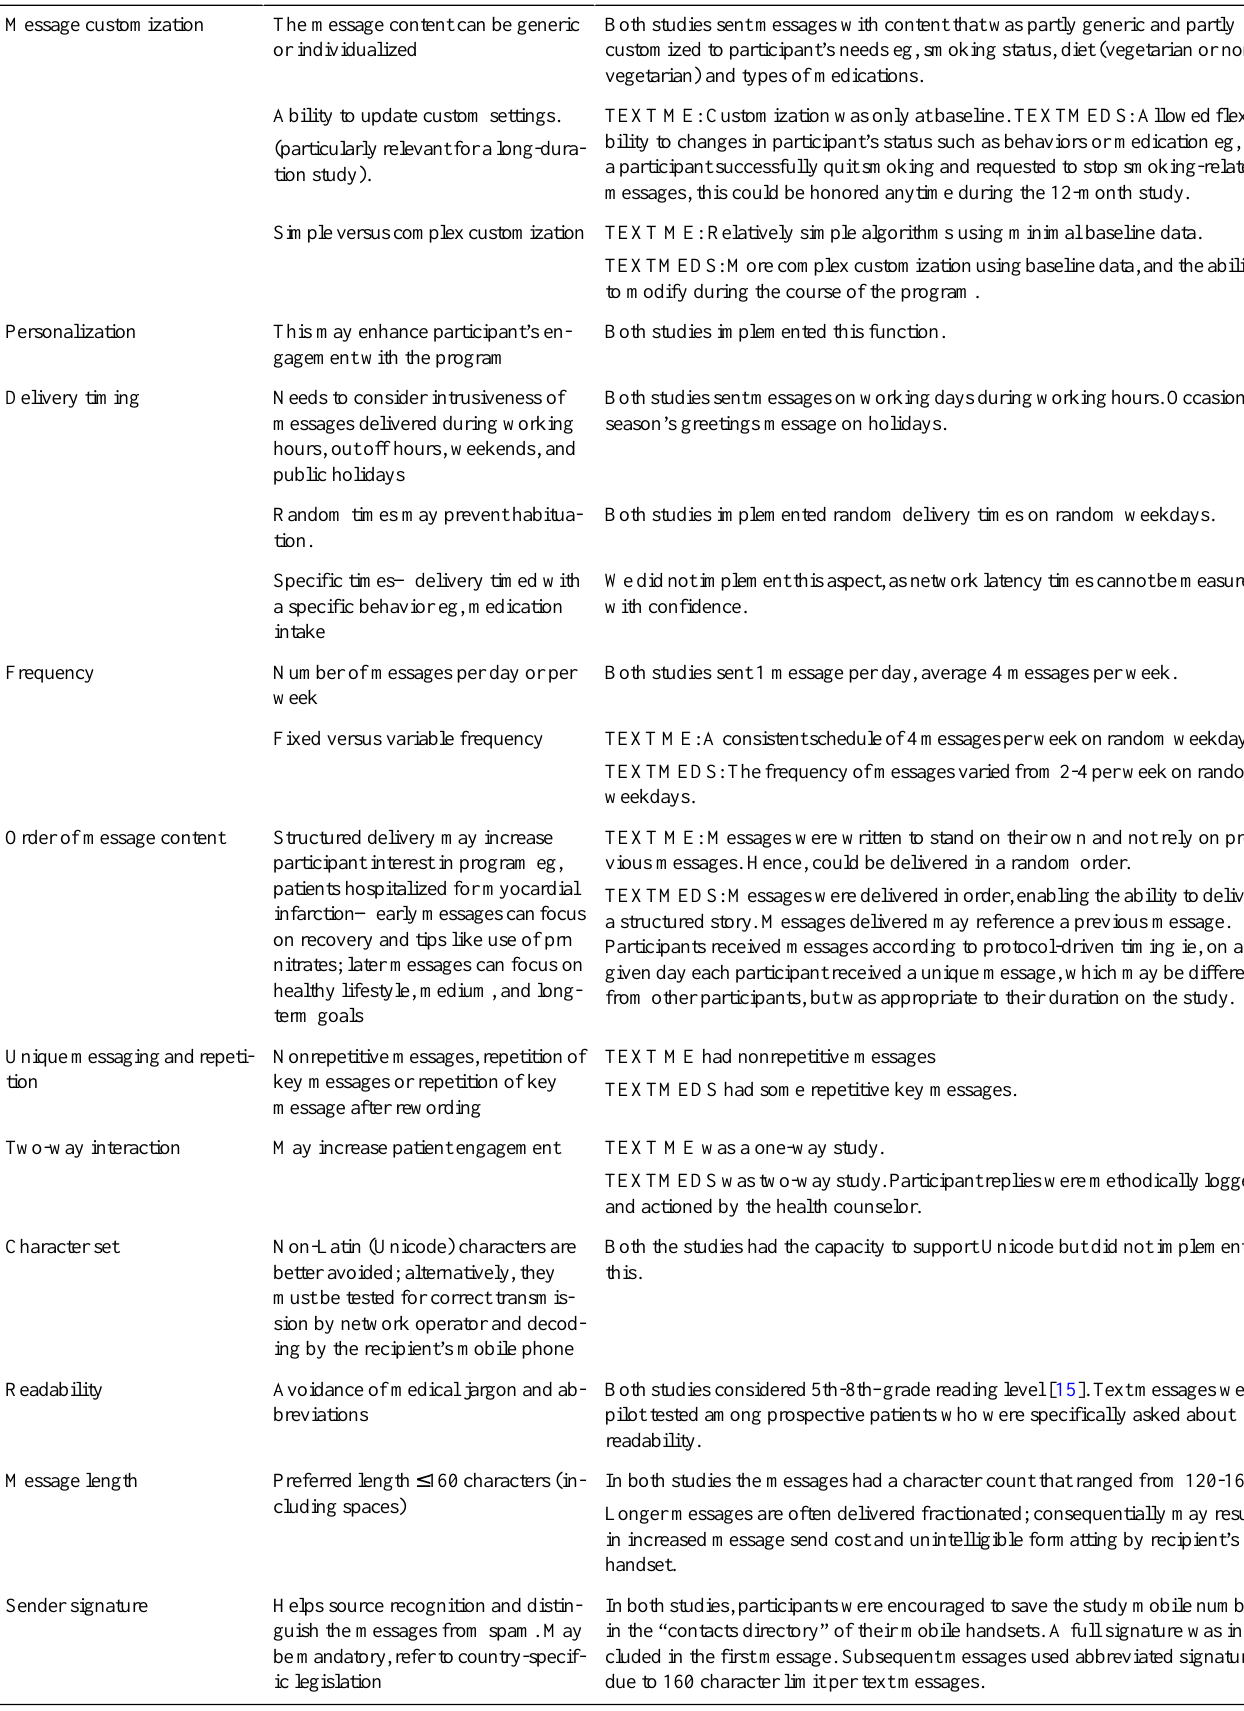
Features adapted in TEXT ME and TEXTMEDS studiesFeaturesText message characteristic Both studies sent messages with content that was partly generic and partly customized to participant’s needs eg, smoking status, diet (vegetarian or non- vegetarian) and types